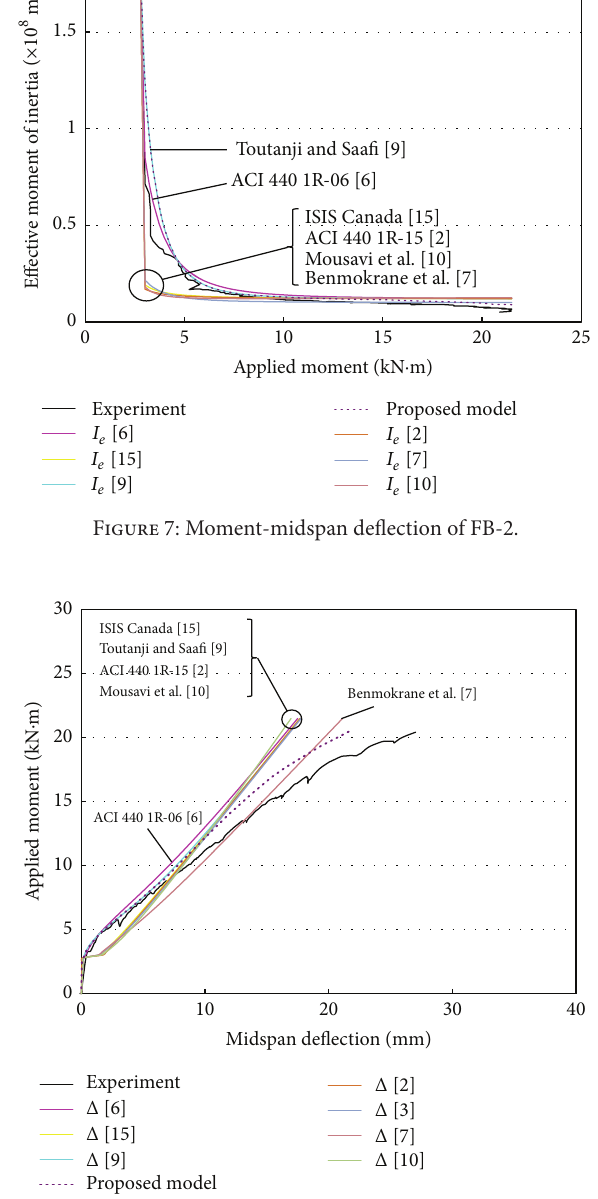
Figure 8: Moment-midspan deflection of